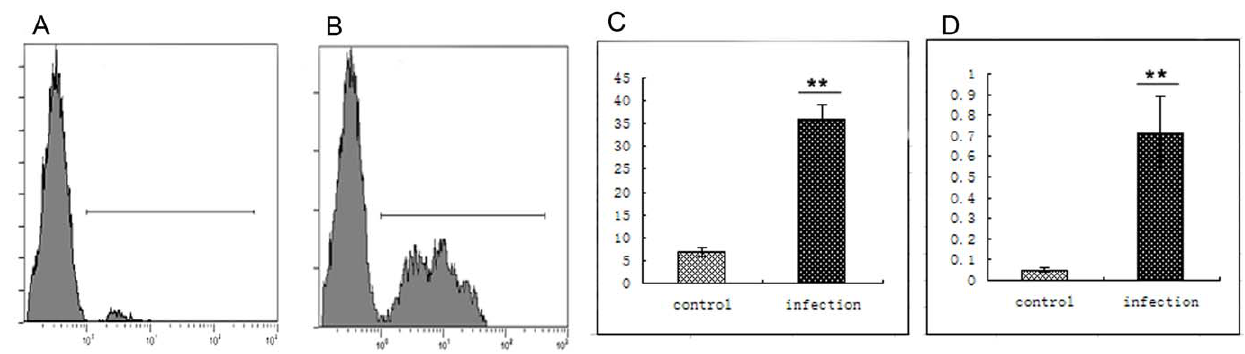
Figure 6. Levels of Qa-1 in mice following T.gondii infection. The levels of Qa-1 protein in placenta and uterus were determined by flow cytometry at six dpi. (A) Qa-1 protein levels in uninfected mice. (B) Qa-1 levels in infected mice. (C) (D) **P , 0.01 versus control group. Experimental and control group each contained six mice.